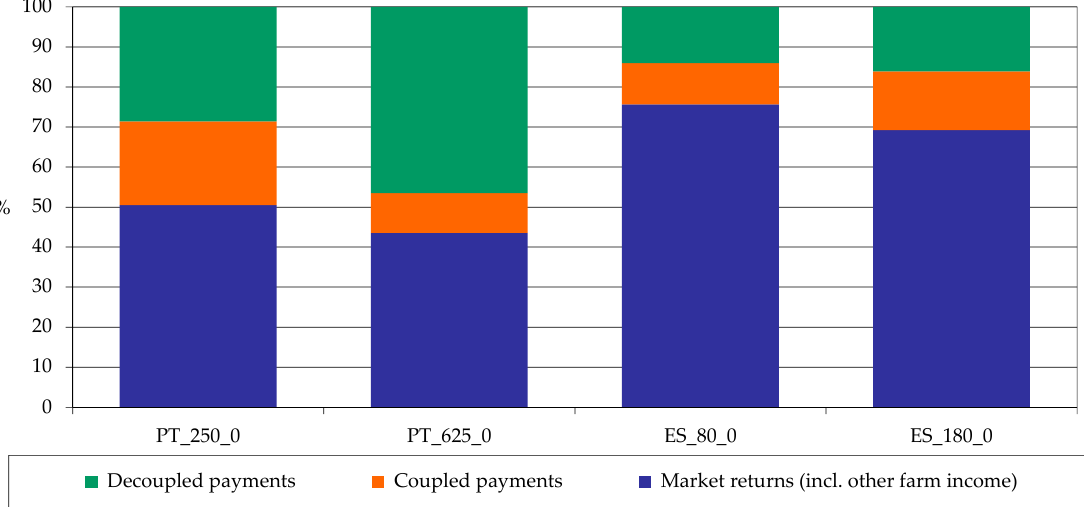
Figure 3. Composition of whole farm returns (%). Source: model results.